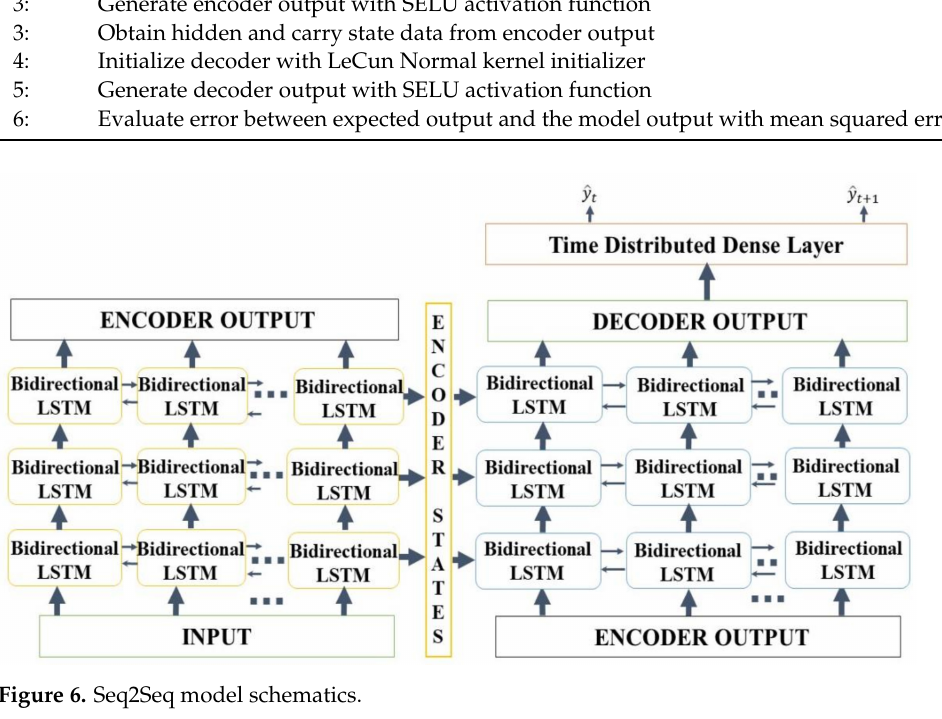
Figure 6. Seq2Seq model schematics.